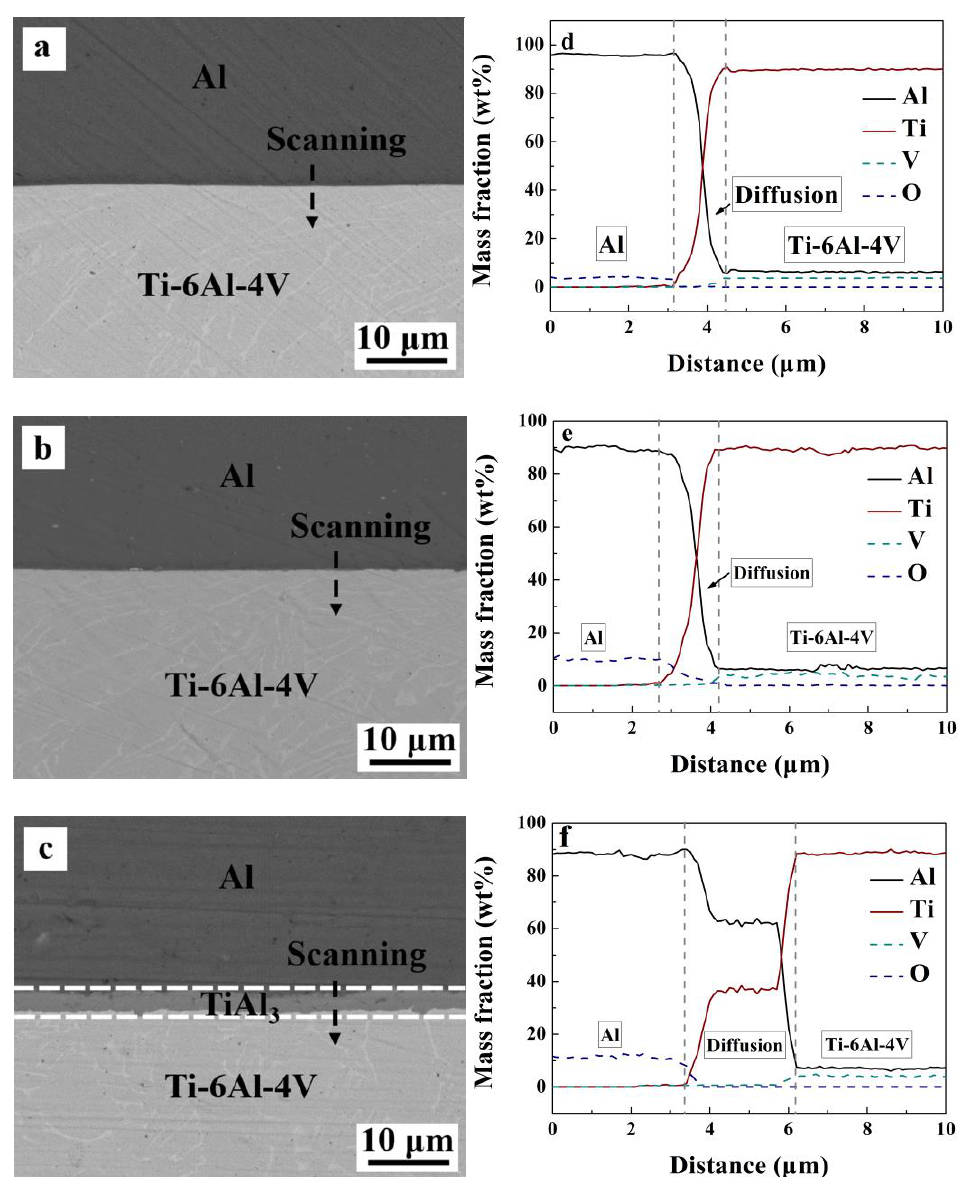
Figure 3. BSE images of cross-sectional Ti-6Al-4V alloy sliding at different temperatures for 10 h: ( a ) 400 °C; ( b ) 500 °C; ( c ) 600 °C. The results of EPMA of lines at the Ti-6Al-4V/Al interface: ( d ) 400 °C; ( e ) 500 °C; and ( f ) 600 °C.